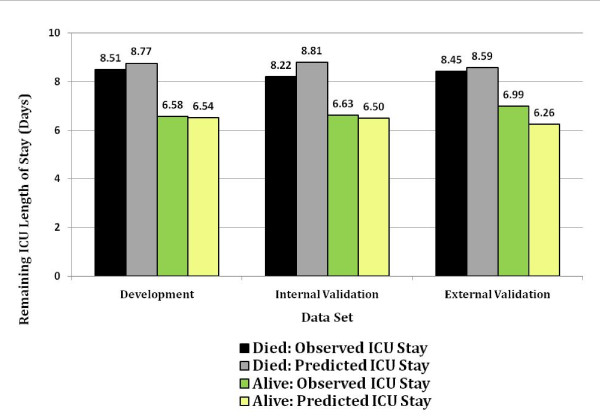
Comparison of mean observed and mean predicted intensive care unit (ICU) length of stay remaining after day 5 among survivors and non-survivors at ICU discharge. Black, died: Observed ICU stay. Gray, died: Predicted ICU stay. Green, alive: Observed ICU stay. Yellow, alive: Predicted ICU stay.